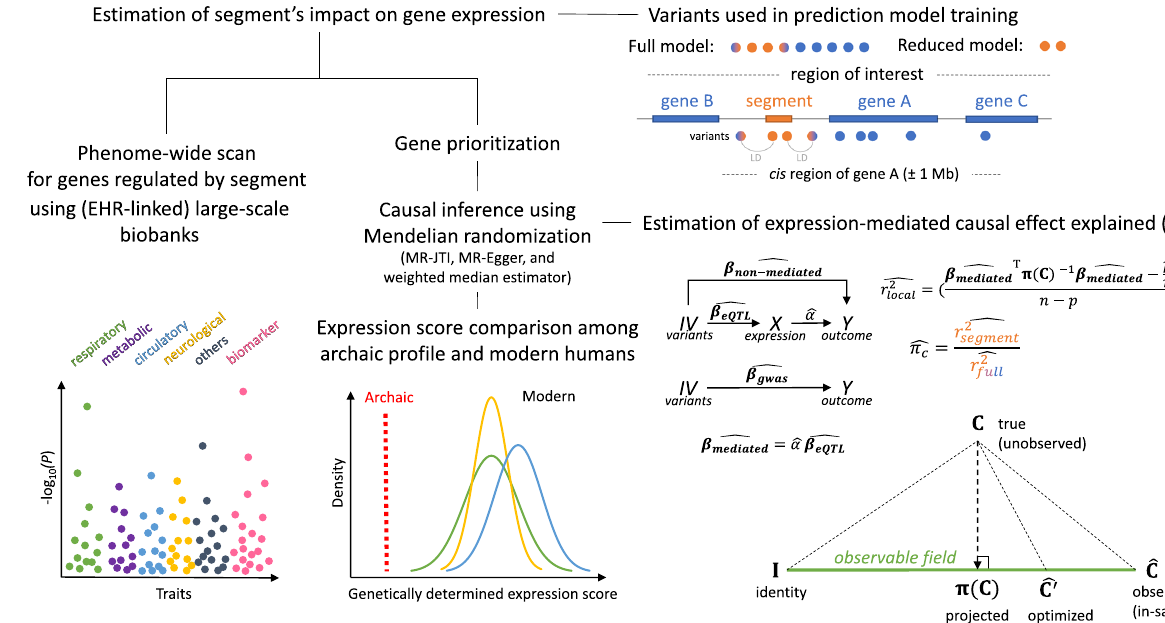
Fig. 1 The framework. We developed an integrative transcriptomic, evolutionary, and causal inference framework for a deep region-level analysis. A segment (shown here in orange) may be a regulatory element, a stretch of DNA under positive selection, or an archaic introgressed haplotype within a potentially larger ‘ region of interest ’ (denoted by a broken line), which may span multiple genes and genetic variants. A segment-based analysis facilitates high-resolution quanti fi cation of the segment ’ s impact on (genes within) the region. The framework provides an approach to segment-speci fi c gene expression heritability estimation using the ‘ reduced model ’ , that is, one trained on genetic variation in the segment using the joint-tissue imputation (JTI) methodology. Region-wide gene prioritization is performed by applying the ‘ full model ’ , that is, a model trained on all local genetic variants, to GWAS summary statistics for maximal statistical power. MR-JTI, a Mendelian randomization approach that extends JTI, estimates causal gene effects by modeling the heterogeneity due to horizontal pleiotropy and unobserved confounding. The genomic sequences are strati fi ed according to evolutionary history (in this case, introgression status). For putative causal genes, genetically determined expression scores (GDE-scores) are compared among ‘ archaic ’ and ‘ modern human ’ genomic sequences to further quantify the evolutionary consequence of the (introgressed) segment. In addition, the proportion of expression- mediated causal effect explained by the segment ð b π c Þ is quanti fi ed using a newly developed summary-statistics-based approach. Notably, we d r 2 optimized the estimation of local heritability